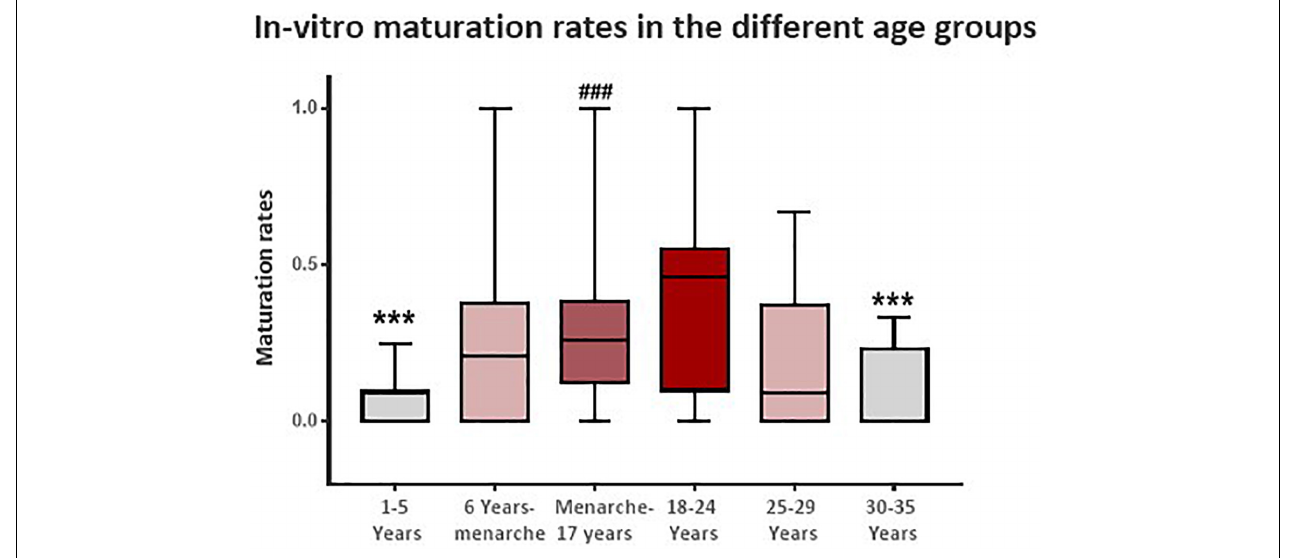
FIGURE 1 | Patient in vitro maturation rate following ovarian tissue cryopreservation according to six age groups – (1) 1–5 years; (2) 6 years to menarche; (3) menarche to 17 years; (4) 18–24 years; (5) 25–29 years; and (6) 30–35 years. *** p < 0.001 when compared to the 18–24 years age group. ### p < 0.001 when compared to the 1–5 years age